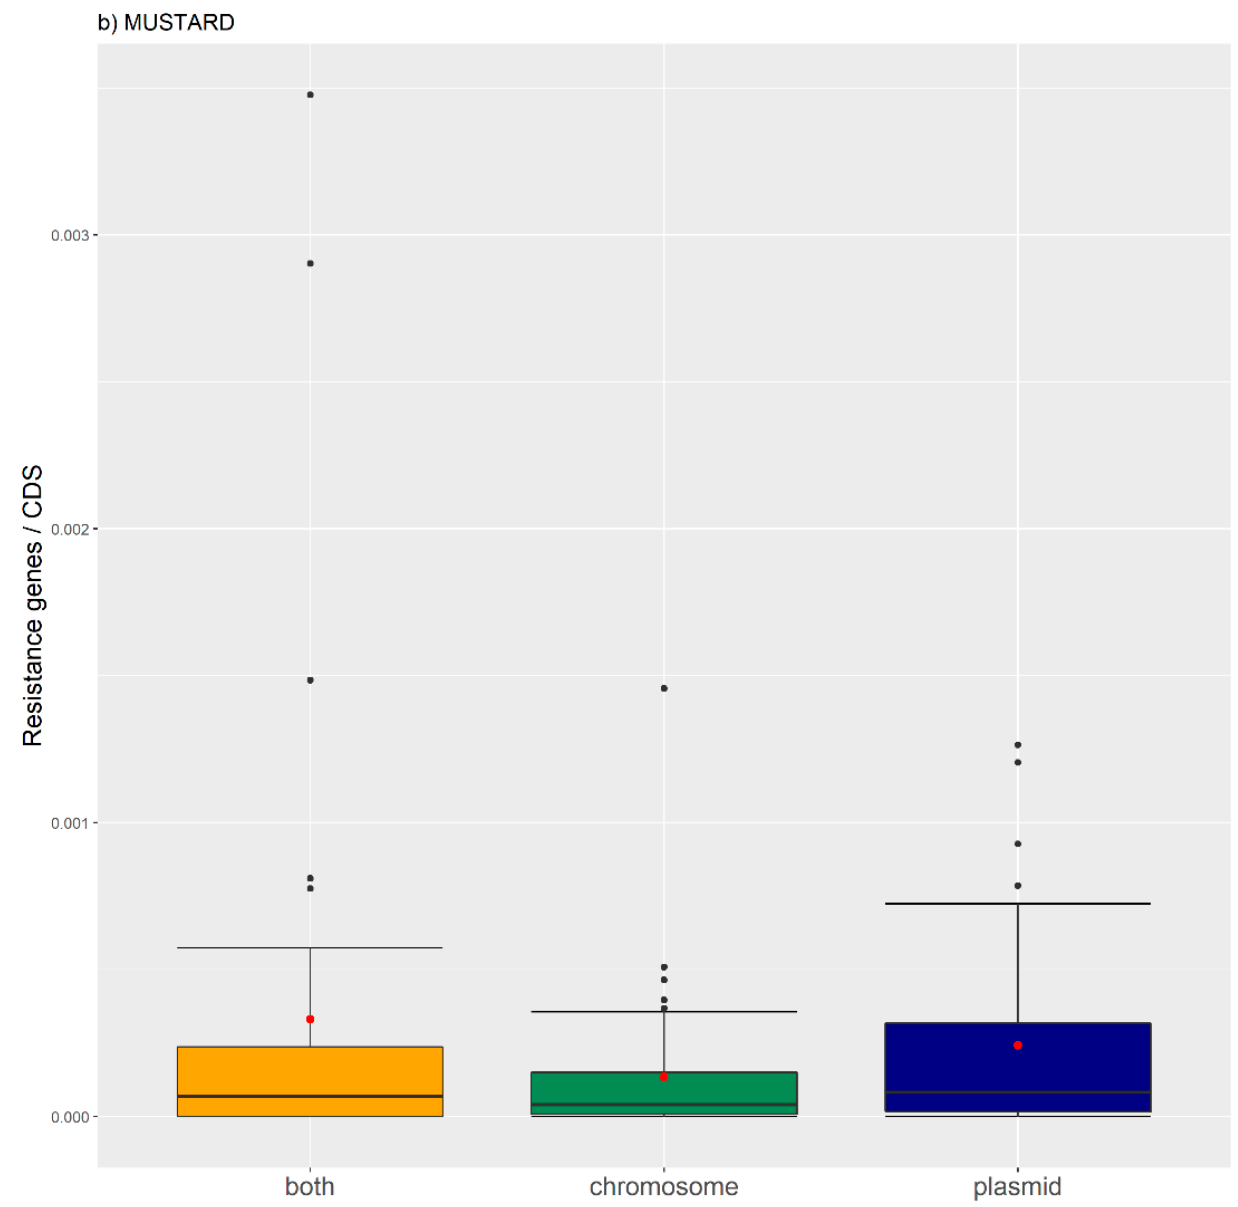
Figure 2. Boxplots of the antibiotic resistance orthologues per genomic location. ( a ) ResFinder orthologues. ( b ) MUSTARD orthologues. The red dot represents the mean.